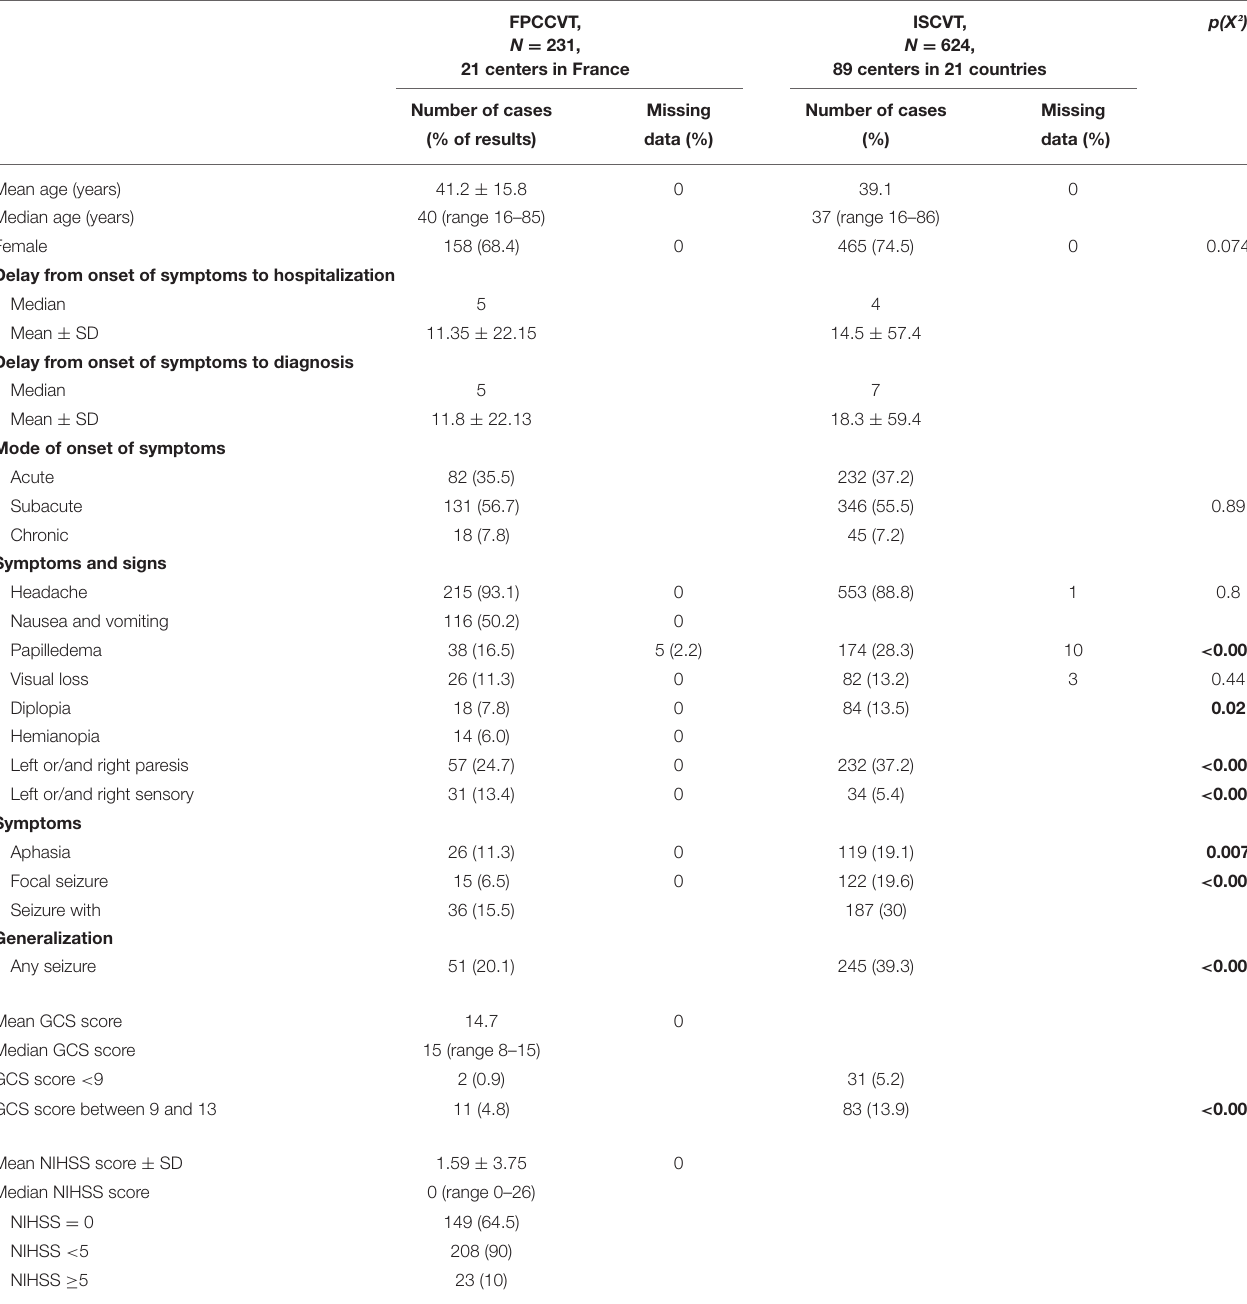
TABLE 1 | Demographic and clinical characteristics of the FPCCVT and ISCVT cohorts at baseline.